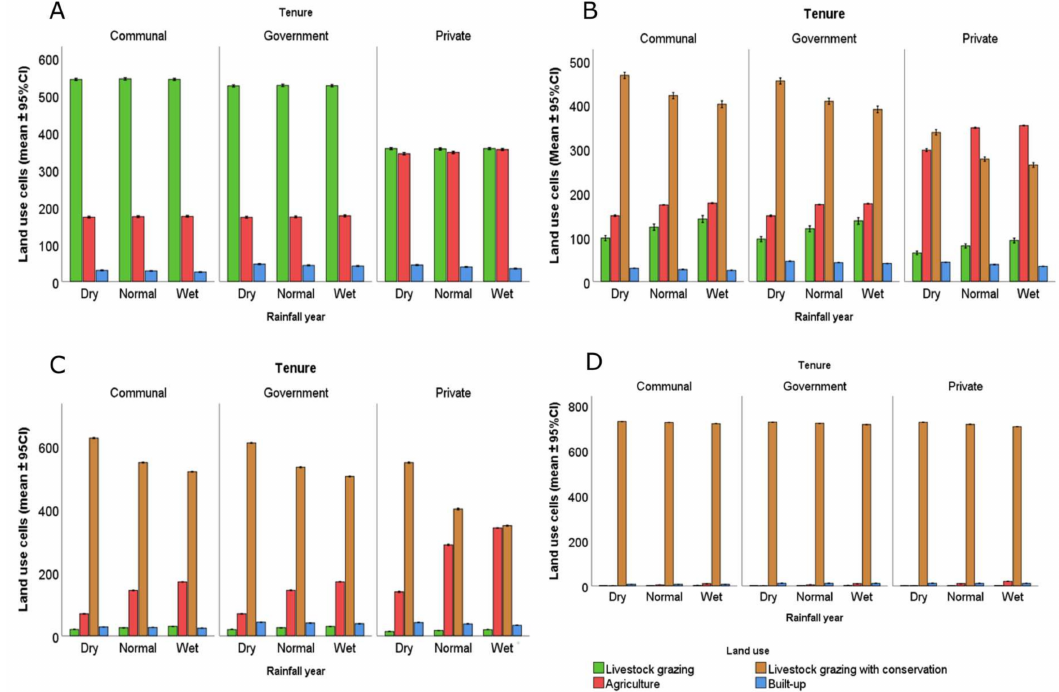
Figure 2. Comparison of land use types at different levels of conservation subsidies in Amboseli. In ( A ) there is no conservation subsidy, in ( B ) the conservation subsidy ranges from 10 to 100 $ year − 1 while in ( C , D ), the conservation subsidy ranges from 110 to 200 $ year − 1 and 210 to 1000 $ year − 1 . In all the graphs, the three land tenure scenarios are labelled as ‘Tenure’. The error bars represent 95% confidence